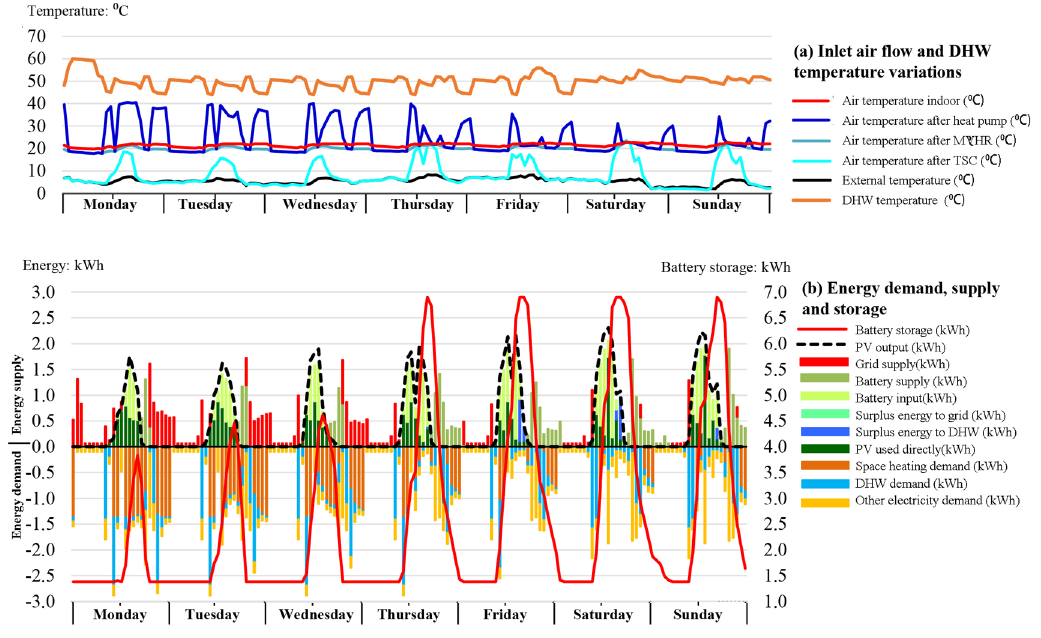
Figure 12. ( a , b ). Winter sunny week: 29 January–4 February.